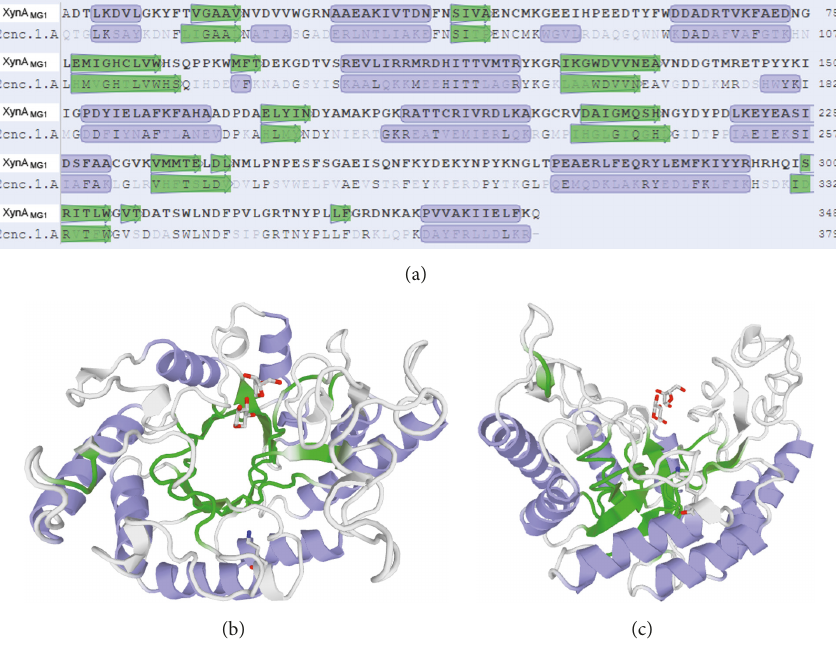
Figure3:StructureofXynA MG 1 modeledusingcrystalstructureofacloselyrelatedGH10endo-xylanase(2cnc.1.A)asatemplate.(a)Predicted secondary structure of XynA MG 1 ; purple box: alpha-helix; green arrow: beta-sheet. (b, c) Three-dimensional representation of XynA MG 1 with alpha-helices, beta-sheets, and loops folded into the typical ( 𝛽 / 𝛼 ) 8 TIM-barrel structure; (b) top view; (c) side view. The XynA MG 1